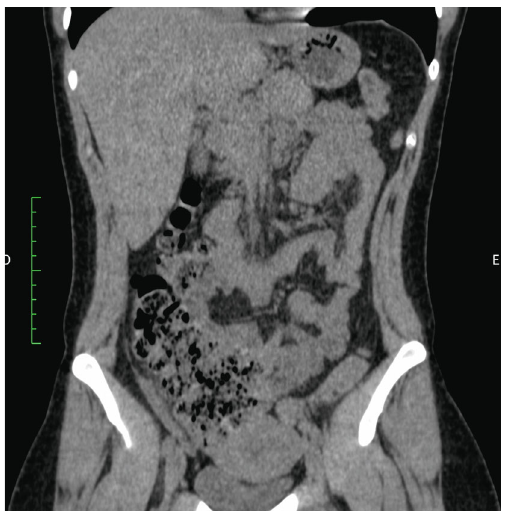
Figure 2: Computed tomography — coronal section.